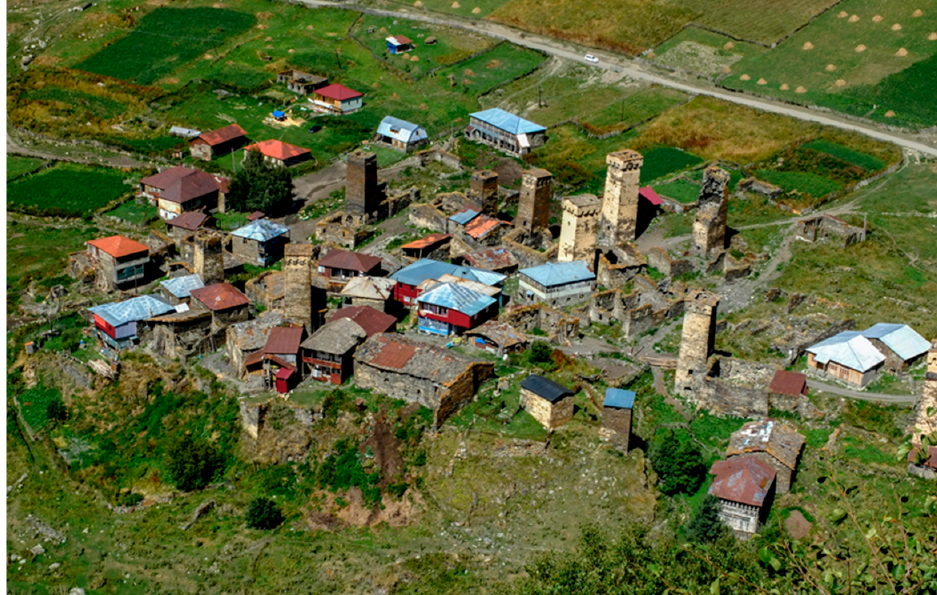
Figure 7. The tin roofing of Murkmeli does not meet the monument requirements; however, the villagers depend on the inexpensive type of roofing (Applis 2015).